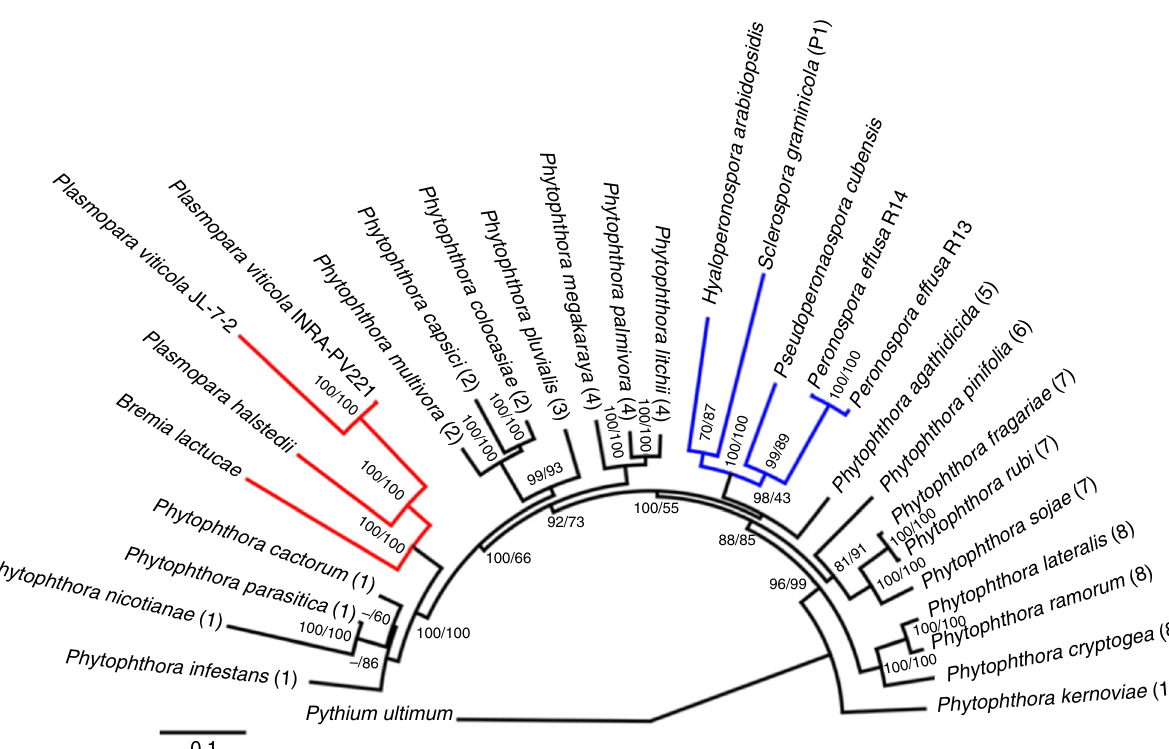
Fig. 3 Polyphyly of downy mildews and paraphyly of Phytophthora spp. Phylogenetic maximum likelihood tree based on the analysis of 18 BUSCO protein sequences across 29 Peronosporaceae species rooted with Pythium ultimum as the outgroup. The 20 Phytophthora species were selected to represent assemblies from the nine published Phytophthora clades indicated by the number in brackets. No assembly from Phytophthora clade 9 was available. Downy mildew clades 1 and 2 are shown in red and blue, respectively. Support for nodes is shown as percent bootstrap values from 1000 iterations of the nucleotide/protein alignments. The output nucleotide and protein trees only disagreed in the order of Phytophthora clade 1 species and are indicated by -- nucleotide support. Scale is the mean number of amino acid substitutions per site. Nucleotide and protein decatenated alignments and output trees are provided as Source Data